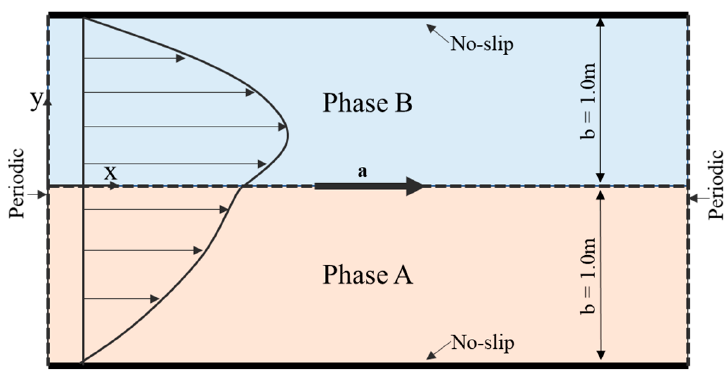
Figure 10. Configuration of two-phase Poiseuille flow test.